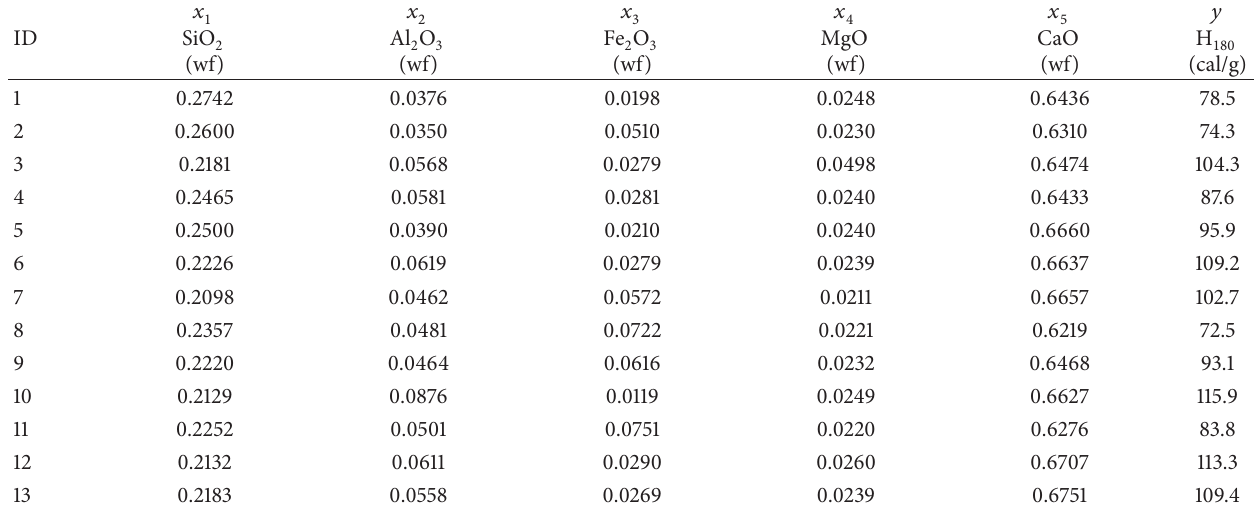
Table 1: Hald cement data.